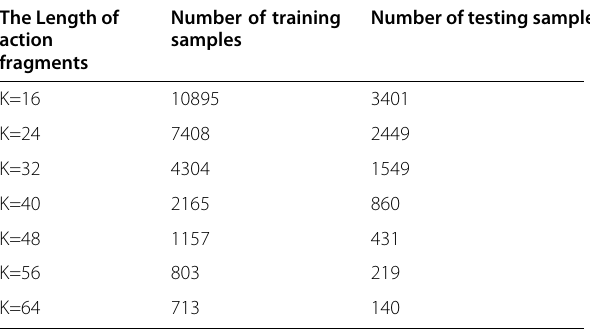
Table 2 Number of samples of different length action fragments generated by MSR Data set